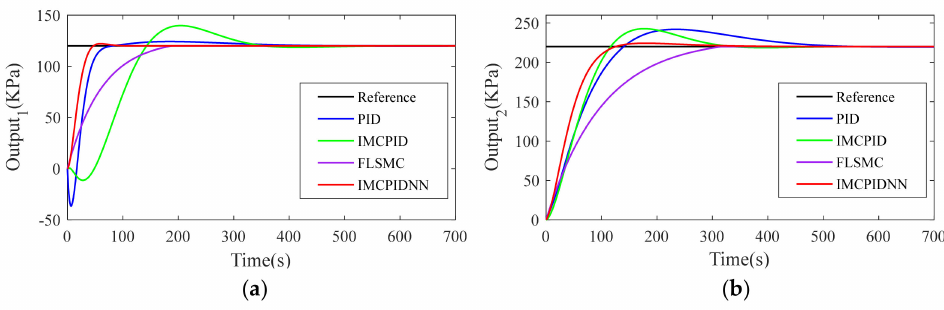
Figure 8. Comparison of concurrent step responses with +20% variation on time constant and gains: